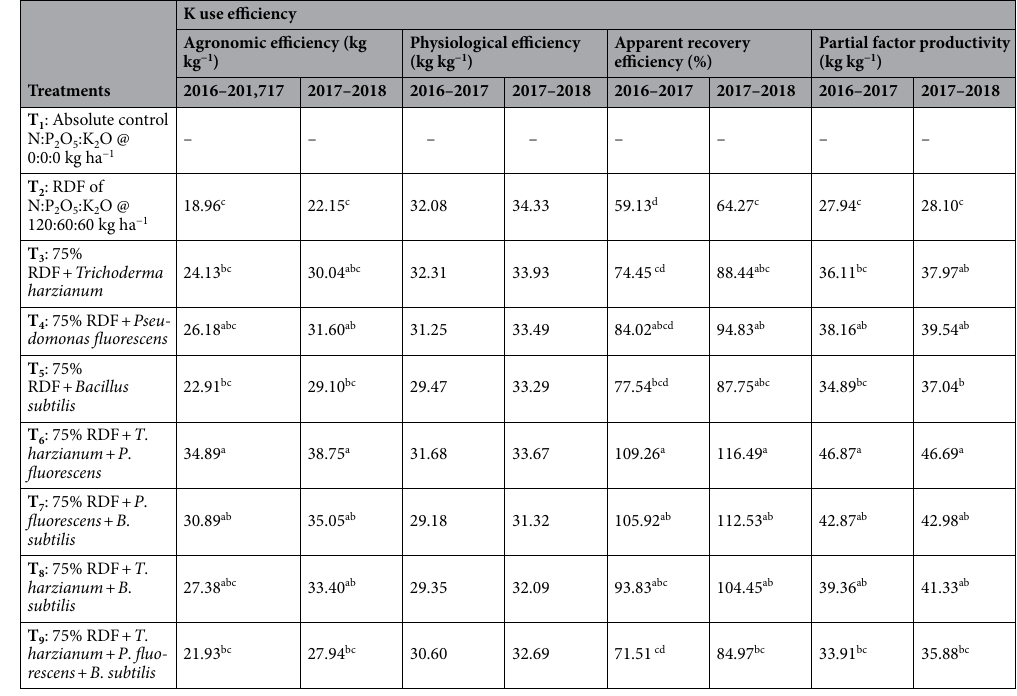
Table 3. Potassium use efficiency of red cabbage as influenced by bio-priming and fertilisation. Different letters indicate significant differences at P ≤ 0.05 among the treatments as per